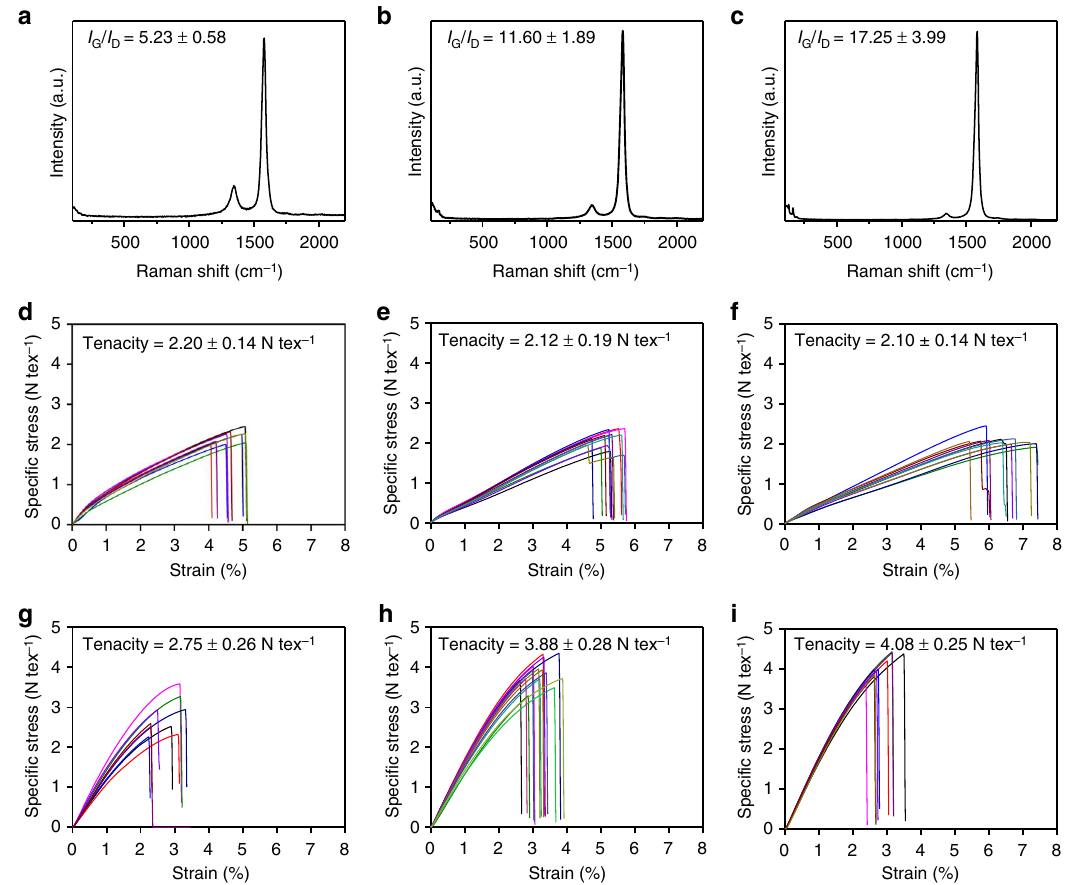
Fig. 4 Effect I G / I D of as-spun CNTFs on the CSA densi fi cation process. Raman spectra of as-spun CNTFs having a a low, b medium, and c high I G / I D . Speci fi c stress – strain curves of as-spun CNTFs having a d low, e medium, and f high I G / I D . Speci fi c stress – strain curves of CSA-CNTFs having a g low, h medium, and i high I G / I